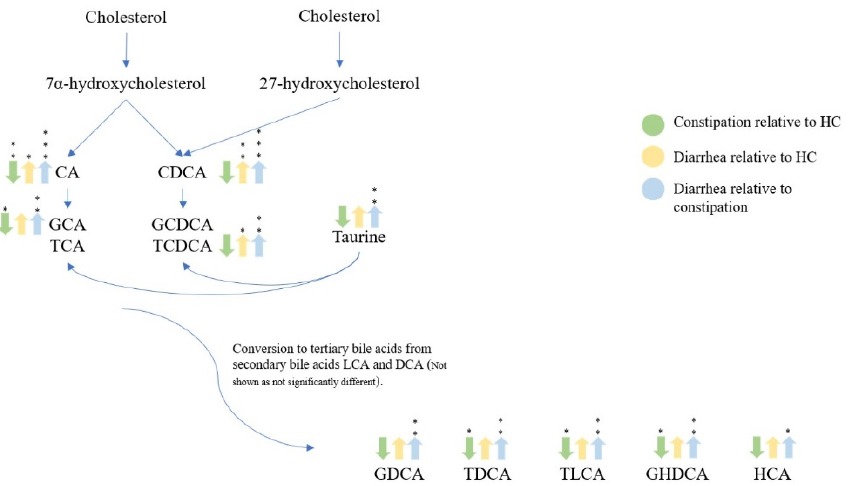
Figure 7. Bile acid pathway visualization showing significant increased or decreased concentrations in fecal samples for healthy control, constipation (FC + IBS-C), and diarrhea (FD + IBS-D) groups. Arrows depict whether the concentration is either up or down relative to the described color in the legend. Statistical significance denoted as p < 0.05 (*), p < 0.01 (**), p < 0.001 (***). Abbreviation: deoxycholic acid (DCA).